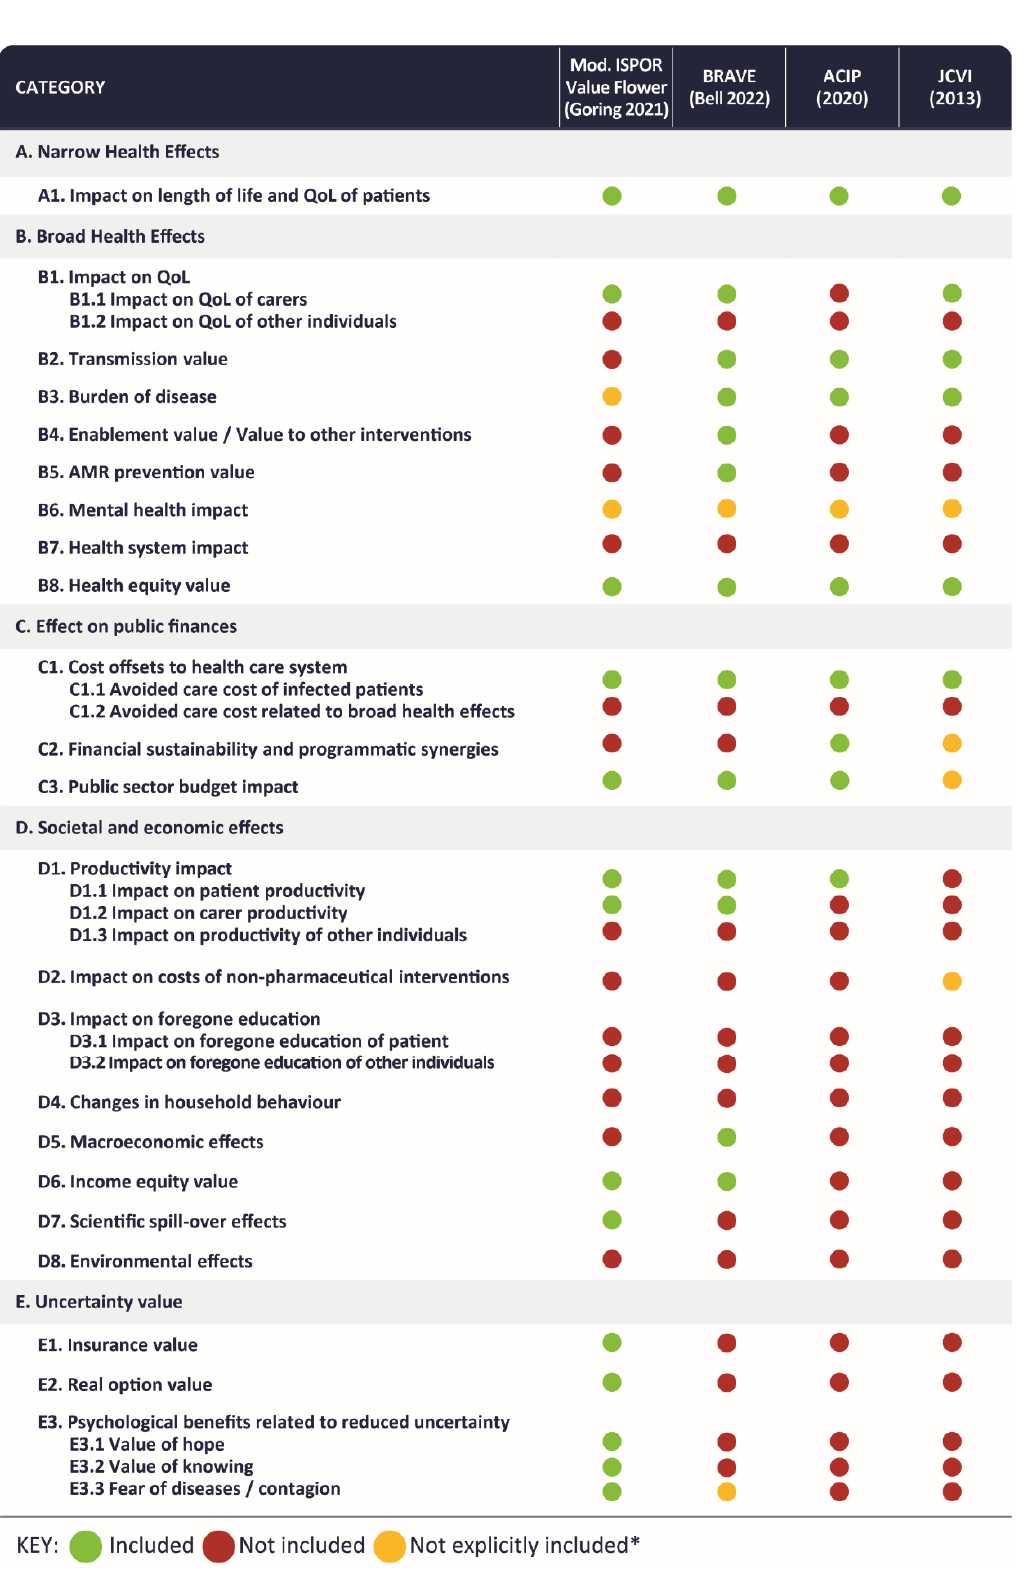
Figure 2. Inclusion of value elements in key value frameworks. ACIP, Advisory Committee on Im- munization Practices (US); BRAVE, Broader Value of Vaccines; JCVI, Joint Committee on Vaccination and Immunisation (UK); QOL, Quality of Life; * Not explicitly mentioned but may be